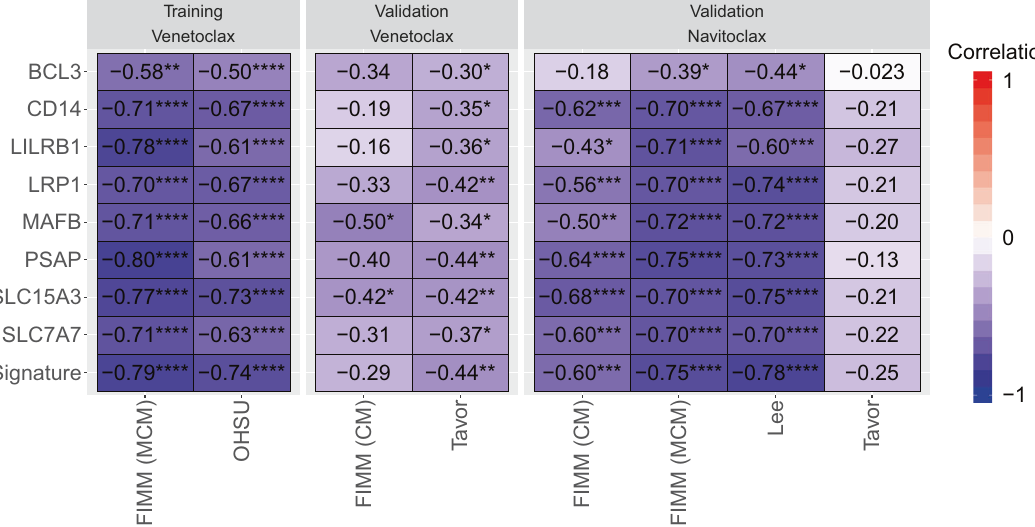
Fig. 6 A monocyte expression signature robustly predicts resistance to BCL-2 inhibitors. Pearson correlation of response of the indicated drug (venetoclax or navitoclax; top) versus expression of the indicated gene or venetoclax monocyte signature (Signature) across FIMM (MCM), OHSU, FIMM (CM), Lee, or Tavor datasets. Dataset/drug combinations are indicated as “ Training ” if they were used to derive the signature and biomarkers and “ Validation ” otherwise. **** p < 0.0001; *** p < 0.001; ** p < 0.01; * p <